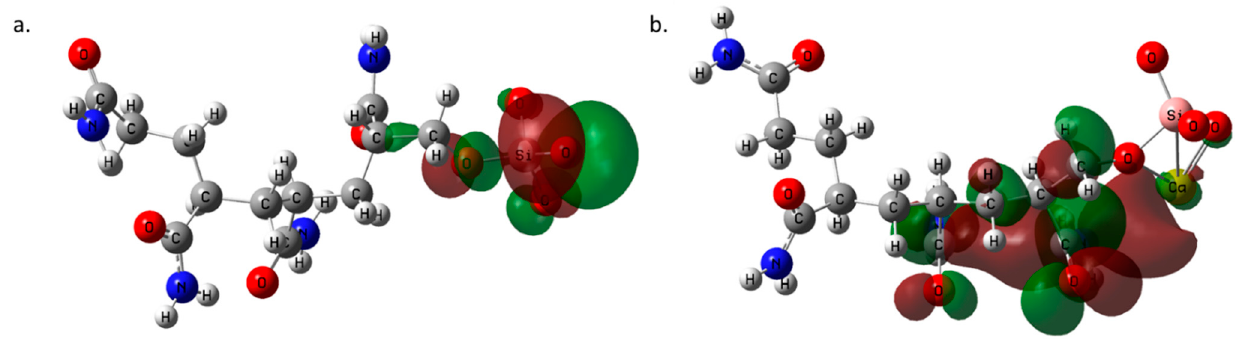
Figure 7. The ( a ) initial and ( b ) final position of the MD trajectory of PAM ‐ Silica with Ca 2+ ions.